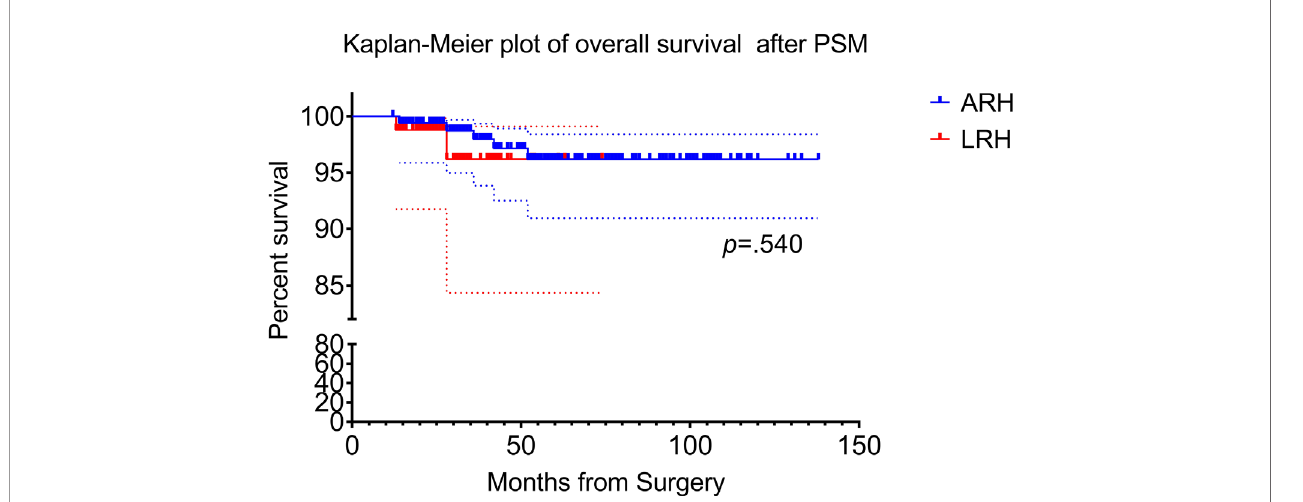
FIGURE 3 | Kaplan – Meier survival curves for laparoscopic radical hysterectomy and abdominal radical hysterectomy. The overall survival (OS) rate of ARH and LRH after propensity score matching.